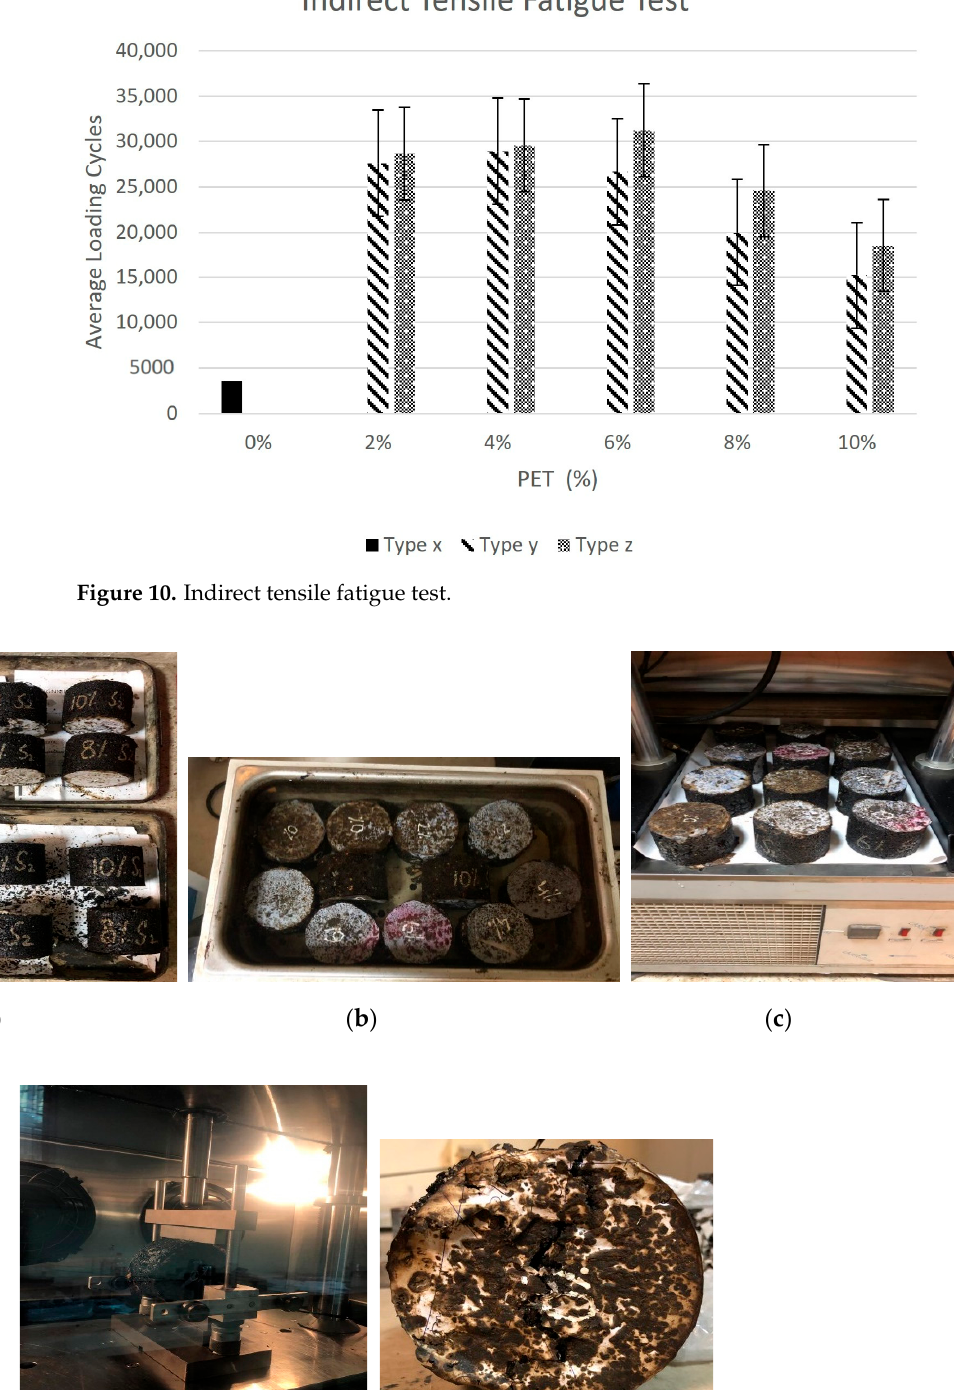
(2) Here: 𝑆 (cid:2870) = average tensile strength of conditioned sample; 𝑆 (cid:2869) = average tensile strength of un-conditioned sample. A minimum TSR value greater than 80%, adopted by many roadway agencies’ spec- ifications [29], was observed for all three sample types. As per the research findings of Ferreira et al., Silva et al. and Ghabchi et al., the resistance against the moisture damage of PET-modified asphalt mixtures was noticeably higher as compared to controlled HMA mixtures [13–15]. Figure 12 shows a graphical representation of average tensile strength